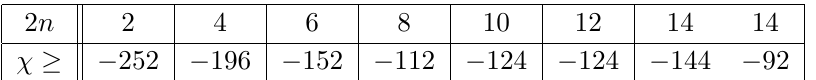
Table 3 . Lower bounds on (cid:31) ( X ) for X ’s that have a regular (cid:3) S = h +2 n i -polarized K3-(cid:12)bration. Two lower bounds are listed for h 2 n i = h 14 i because we can construct two inequivalent lattices L . The linear coe(cid:14)cient of n on the right hand side of (2.48) is positive for any j (cid:13) j j (cid:13) j G = (cid:6) , because we have used a lattice theta function for (cid:30) . Then the lower bounds on n S lead to a lower bound on (cid:31) ( X